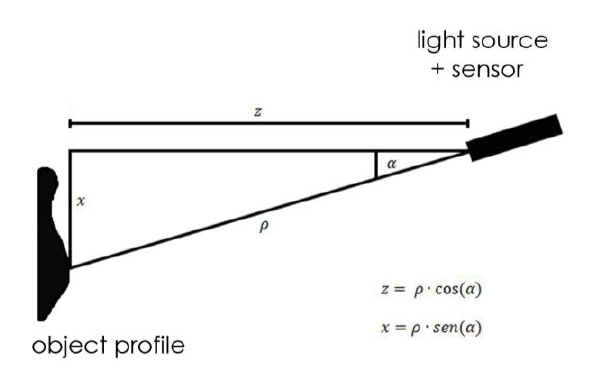
Figure 4. Schematic diagram of a time of flight scanner